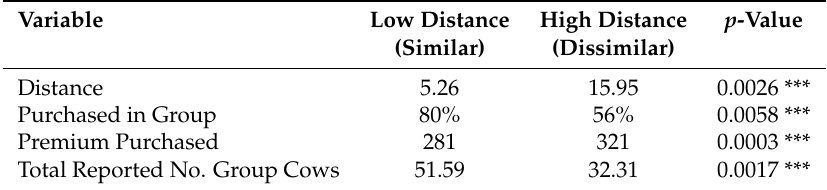
Table 6. Mean Values Across Low and High Distance